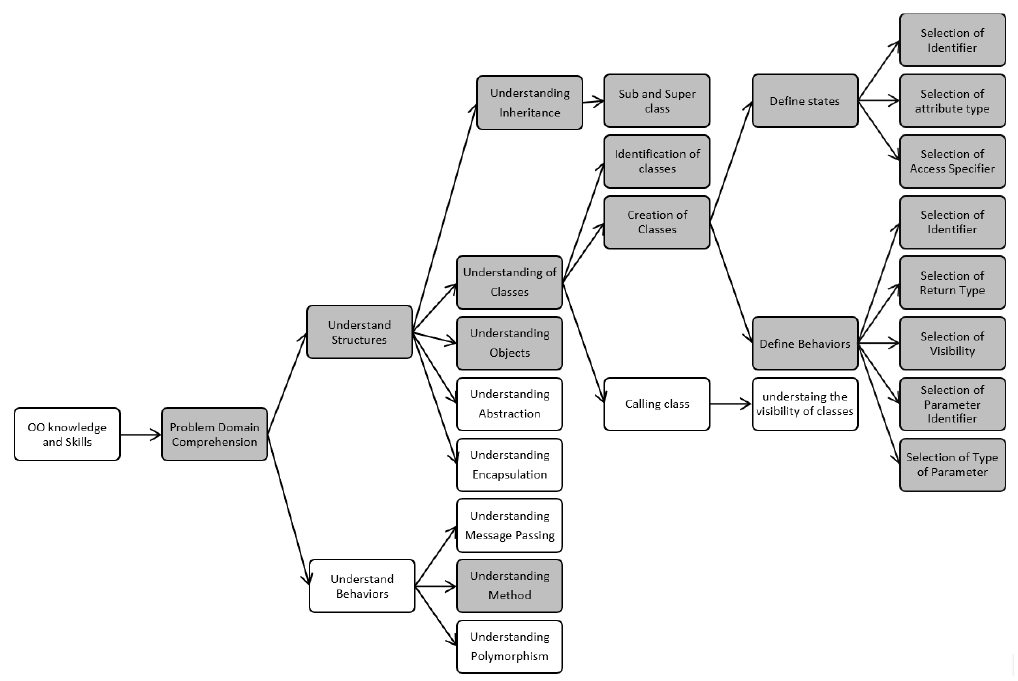
Figure 1. Designed competency model for mastering Object-Oriented Programming (OOP)